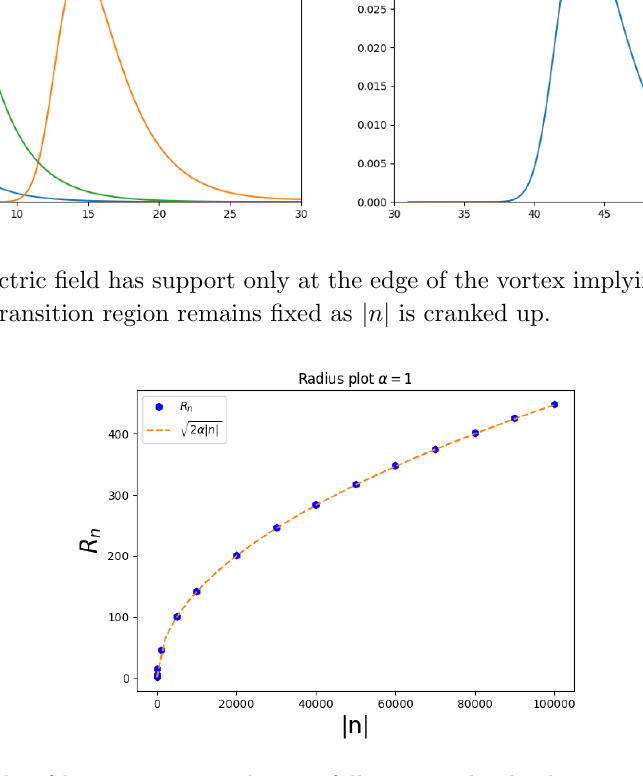
Figure 4 . The radii of large- n vortex solutions follow very closely the curve (cid:22)R n = de(cid:12)ne the radius of the vortex as the position at which the dimensionless energy density falls below a threshold (cid:24) 10 (cid:0) 4